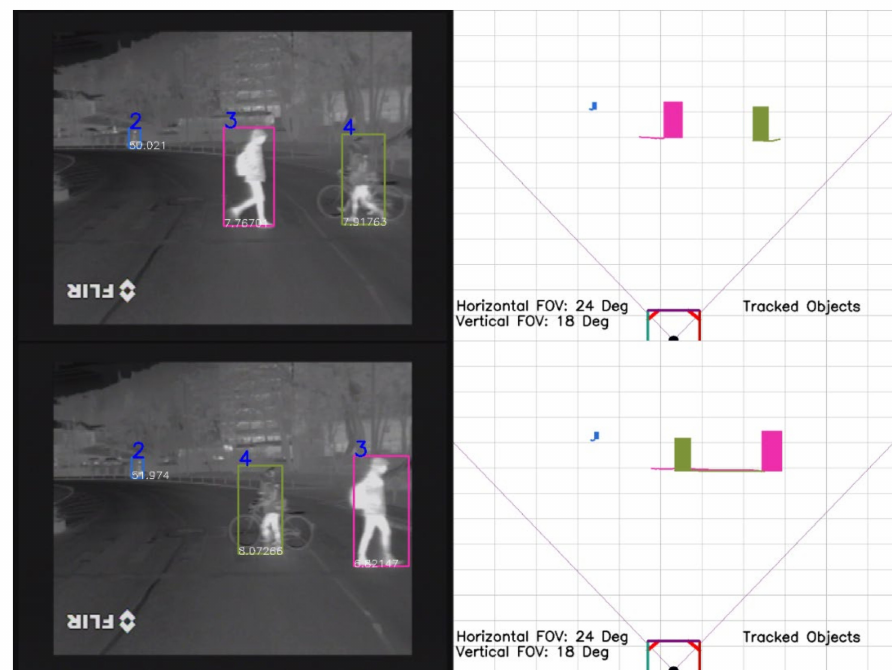
Figure 6. Pedestrians overlapping as they are crossing the street. The tracker is able to maintain the correct object ID and not latch onto the wrong object. Both the top two and bottom two images represent the same tracked objects seen at different time stamps.